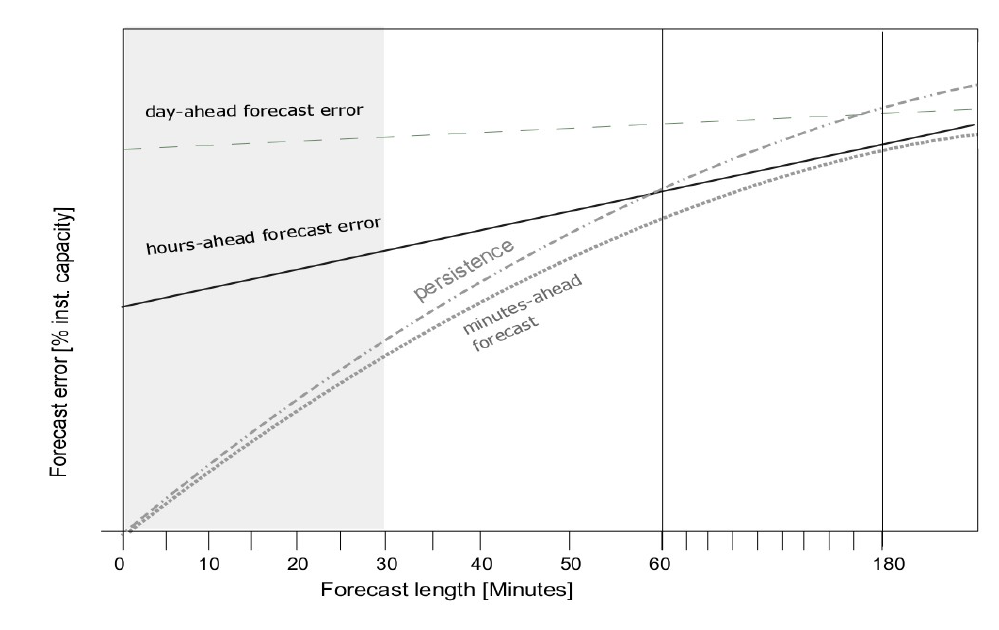
Figure 3. Qualitative visualization of the forecast error development over the first hours of a forecast for different temporal forecast